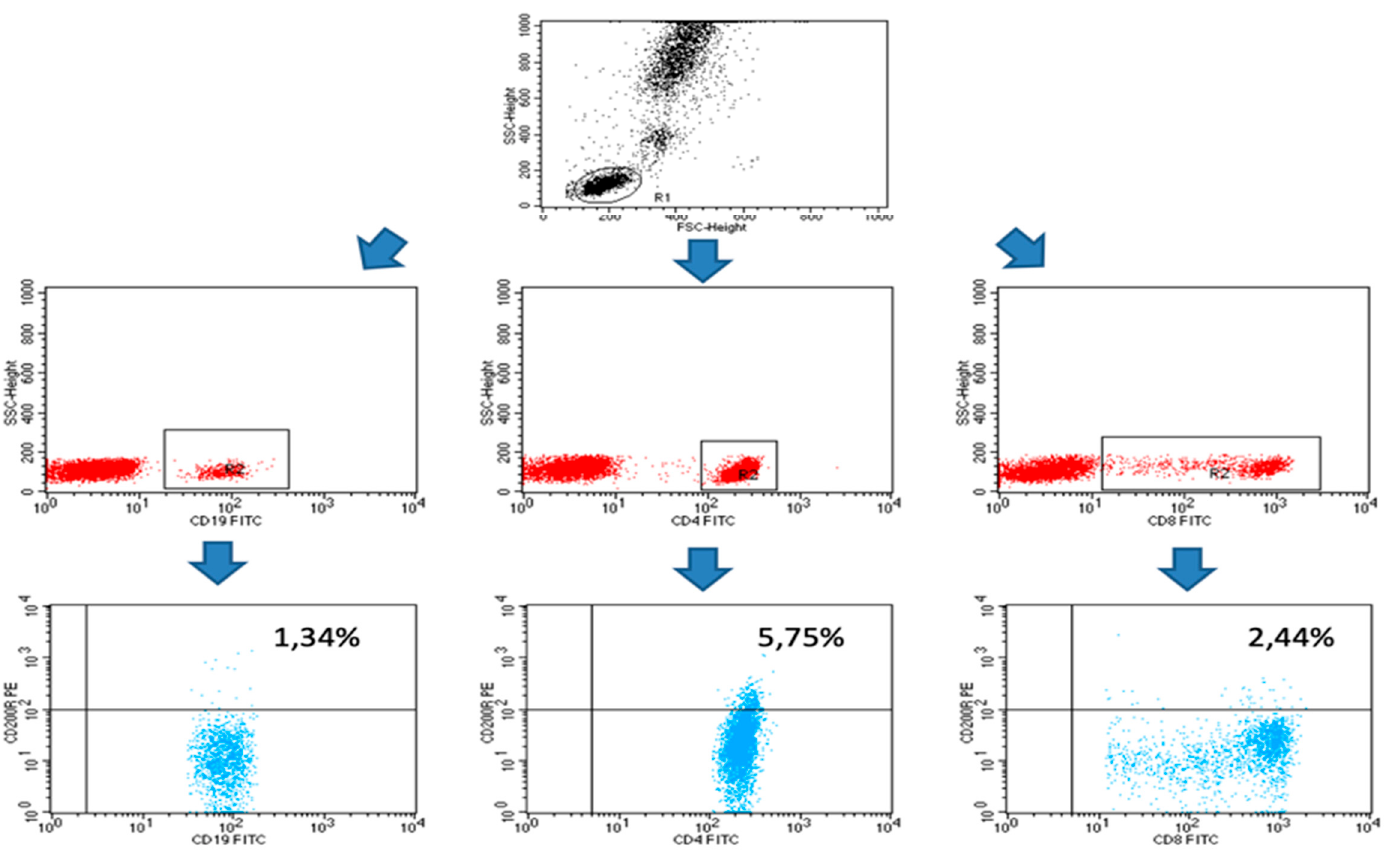
+/ CD8 +/ CD200R T lymphocytes and CD19 +/ CD200R B lymphocytes in EMS Figure A2. Sample analysis of CD4+/CD8+/CD200R T lymphocytes and CD19+/CD200R B lymphocytes in EMS patients. Figure A2. Sample analysis of CD4